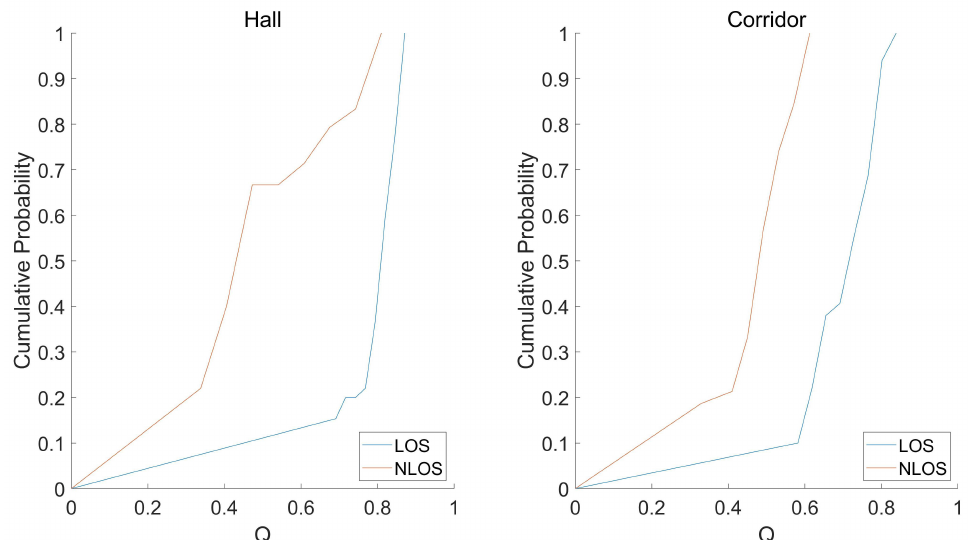
Figure 9. CDF of Q in the ranging experiments.